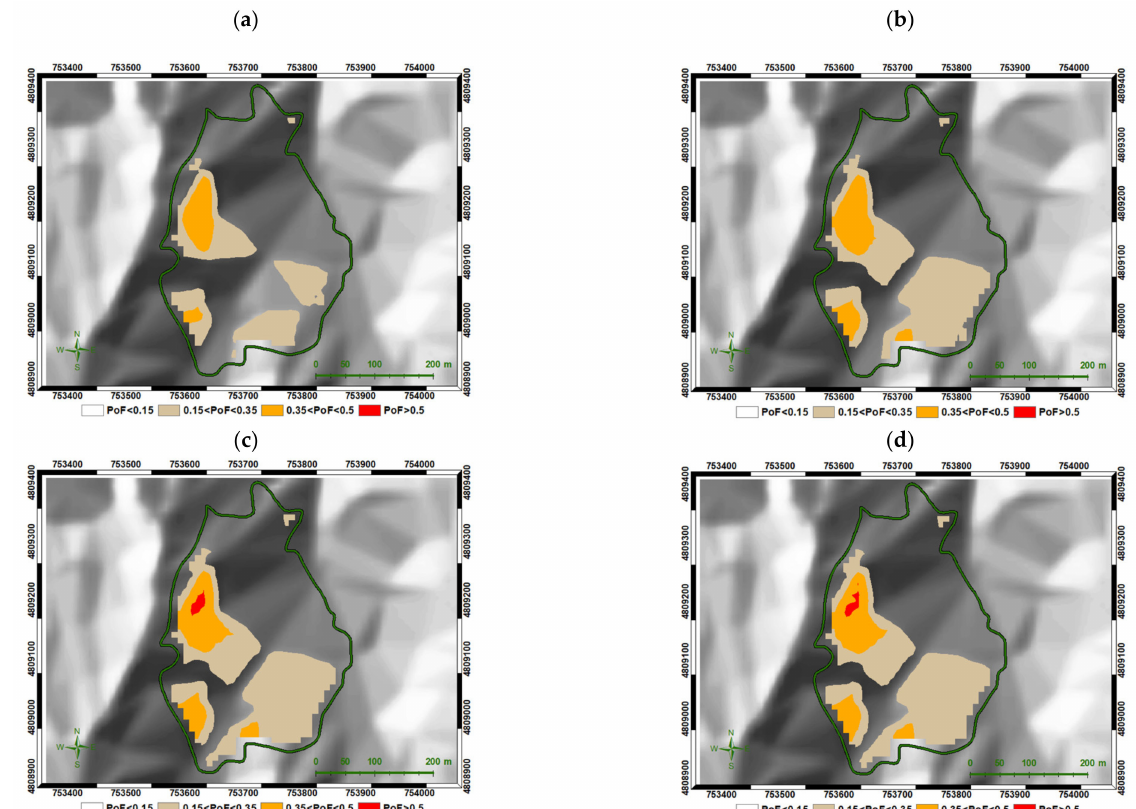
Figure 4. Maps of the probability of failure computed considering the uniform pdf (PoFu) for the random variables in input in the PB model. ( a ) td = 8 h; ( b ) td = 16 h; ( c ) td = 24 h; ( d ) td = 32